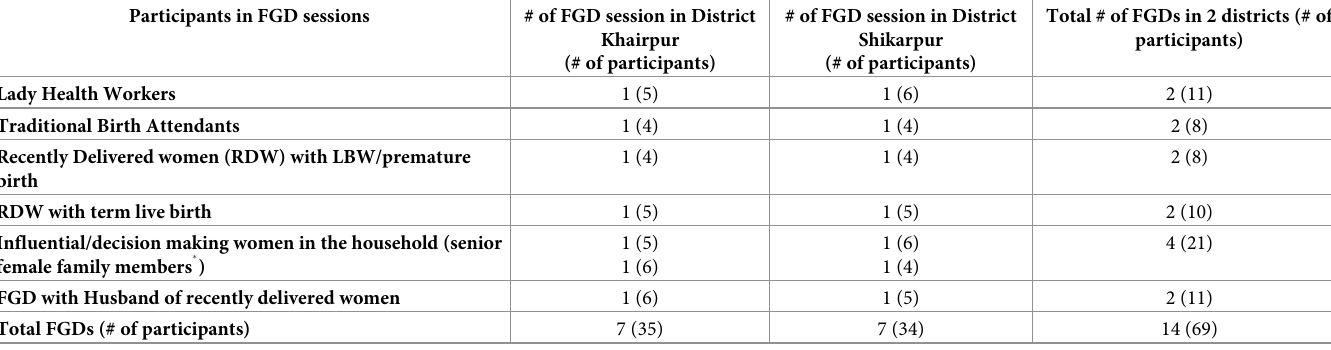
Table 2. Number of focus group discussion (FGD) sessions